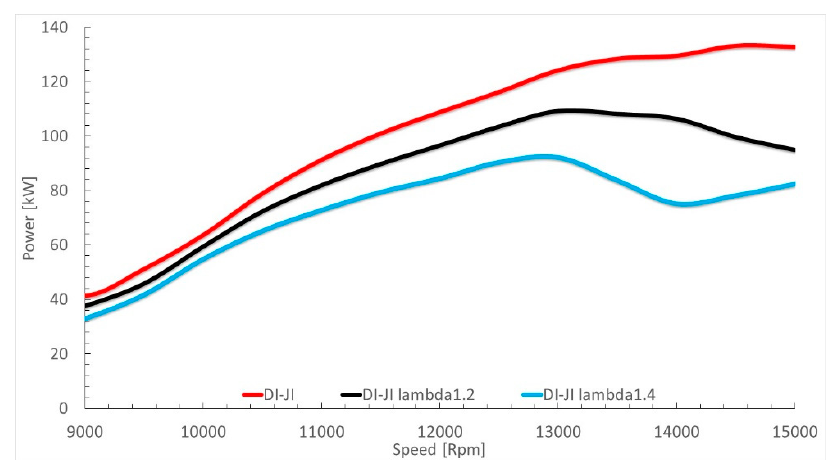
Figure 10. Power of stoichiometric and lean burn engines.